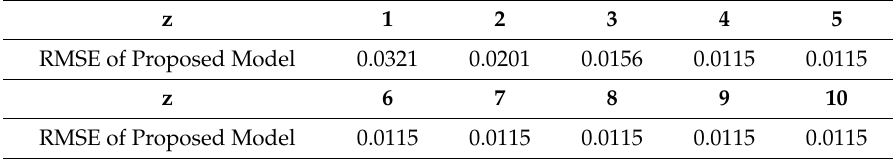
Table 1. RMSE of proposed model when selecting the input icing thickness data at different time point. z 1 2 3 RMSE of Proposed Model